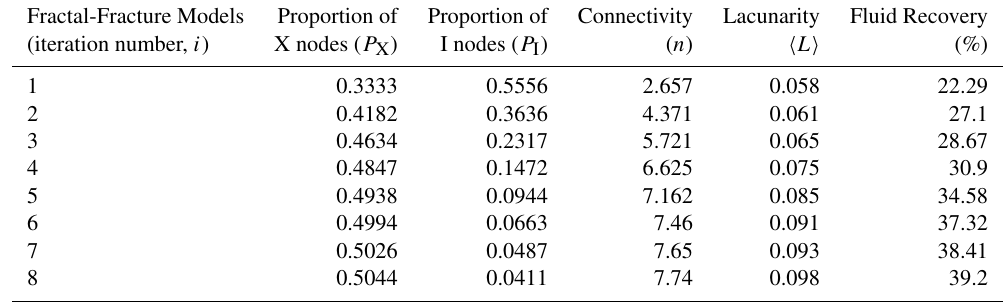
Table A1. Connectivity ( n ), Lacunarity ( (cid:104) L (cid:105) ) and Fluid Recovery (%) of Deterministic Fractal-Fracture Networks from i = 1–8. Fractal-Fracture Models Proportion